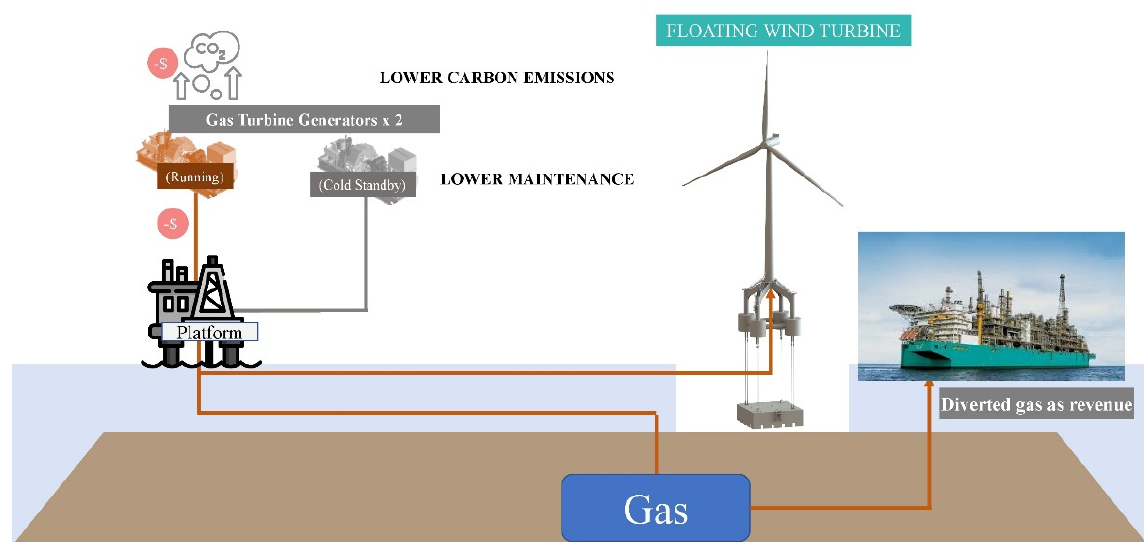
Figure 3. Hybrid power generation concept.